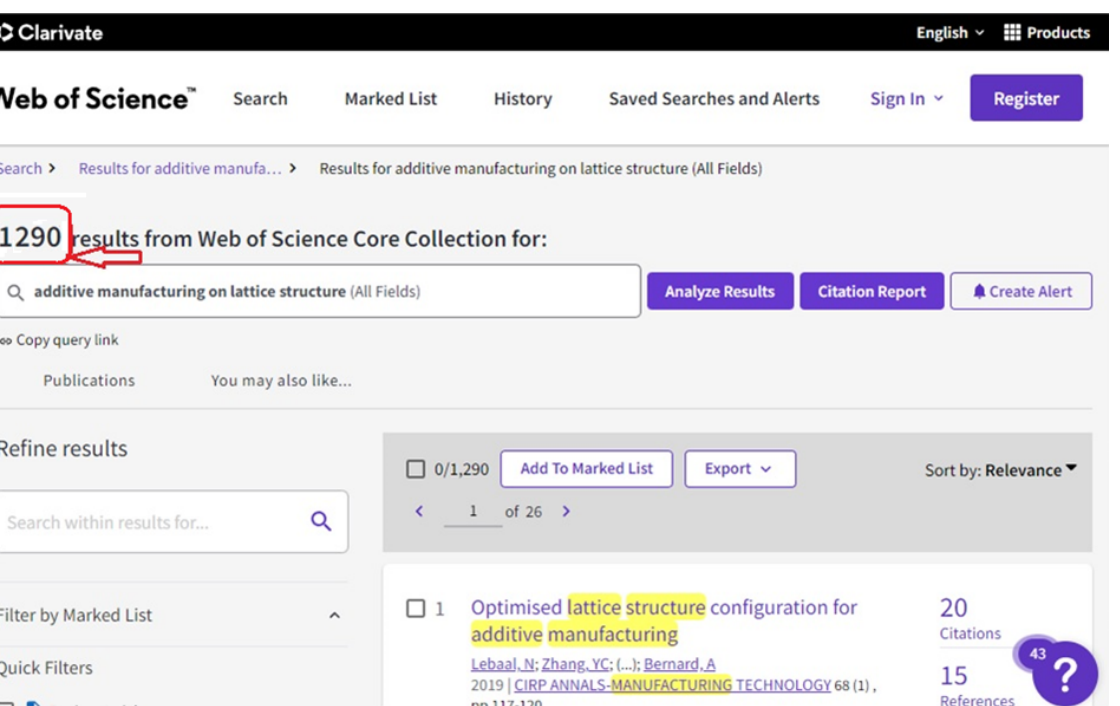
Figure 4. Web of Science (WoS) database supplied by Lancaster University UK, showing keyword “additive manufacturing on lattice structures” for meta-analysis (on 20 June 2022).